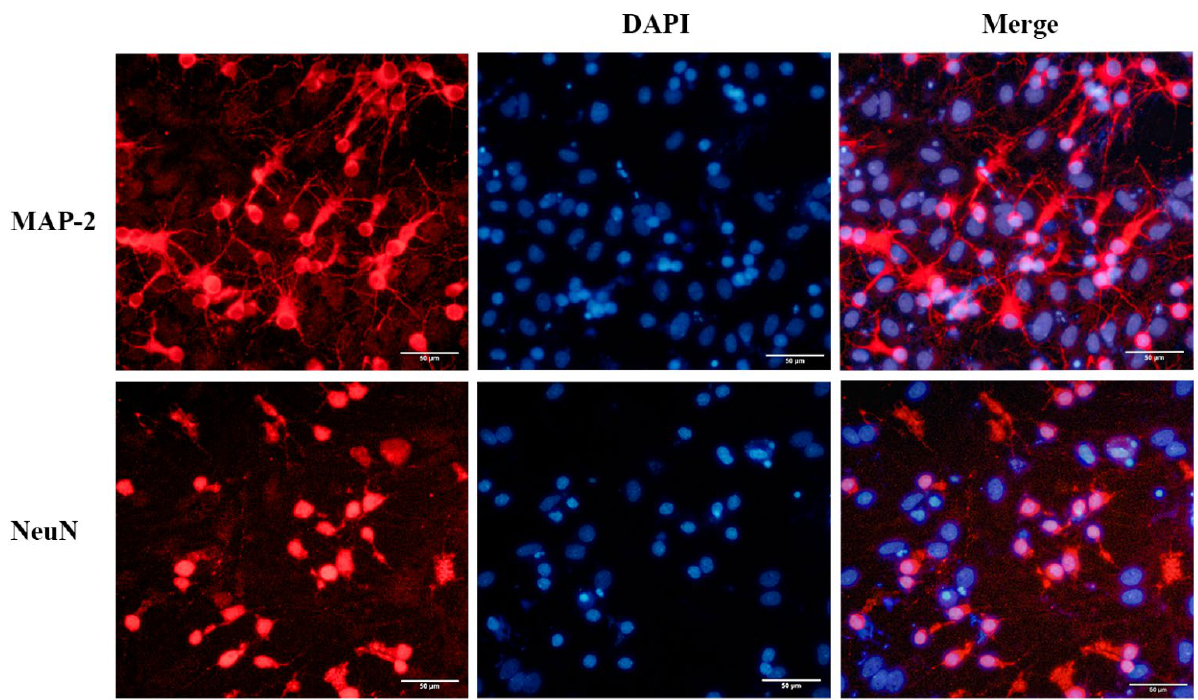
Figure 1. Immunofluorescence staining of primary cultured neurons from the neonatal mouse cortex. The neurons were immunostained to detect MAP-2 (red) and NeuN (red), and cell nuclei were stained blue with DAPI. Scale bar = 50 μm. Neurons SYT-1 is a presynaptic marker protein essential for fast, synchronous neurotransmit- ter release in hippocampal neurons [21]. NF-L is a cytoskeletal protein that is abundantly expressed in neuronal axons. The optimal time and concentration of BG45 were screened by the CCK-8 method.